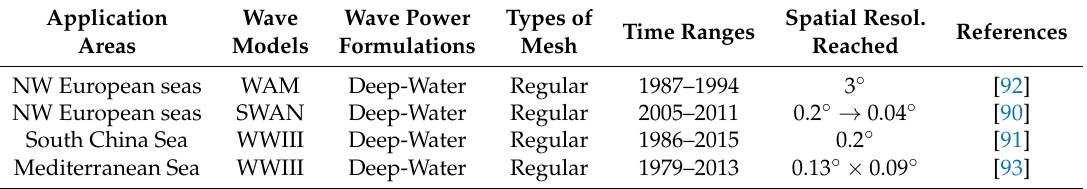
Table 6. Examples of shelf-scale numerical wave energy resource assessments.